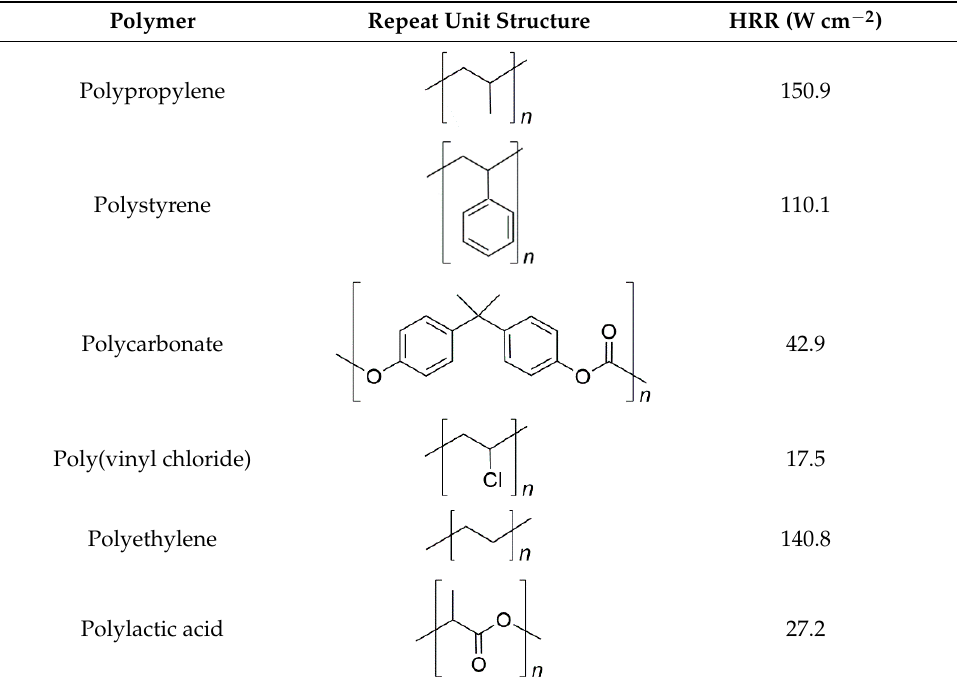
Table 4. Heat release rates (HRRs) of several polymers. Ref. [142].